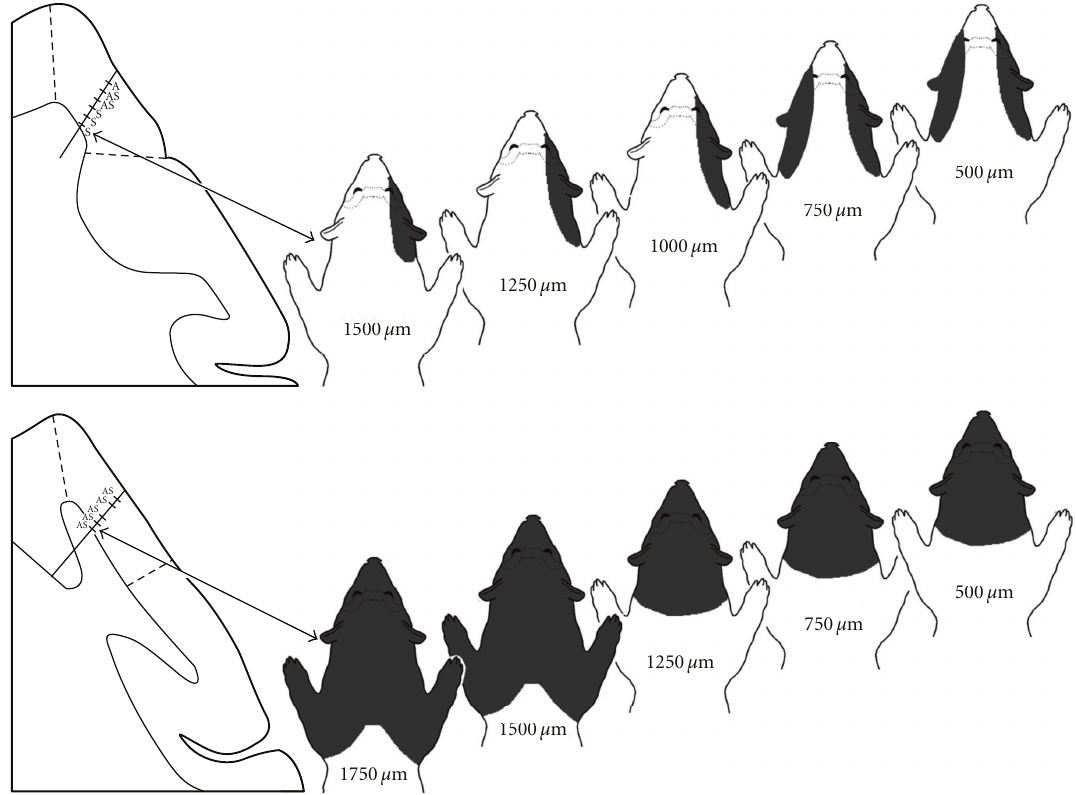
Figure 6: Distribution of somatosensory receptive fields across the cortical mantle (gray matter) of core auditory cortex in early hearing- impaired ferrets. Segments of coronal sections through core auditory cortex (left) show the location of a particular recording penetration and the sensory responsiveness of the neurons identified (A = auditory, S = somatosensory; AS = auditory and somatosensory). To the right, the series of ferret body surface depictions indicate the location of the somatosensory receptive field (shaded dark gray) and depth (in microns) corresponding to the neuron and recording penetration plotted on the tissue section. These data show that somatosensory reorganization of core auditory cortex in early hearing impaired ferrets was robust across the fullthickness of the cortex, represented the anterior segment of the body, and was often bilateral (on the ipsi- and contralateral body